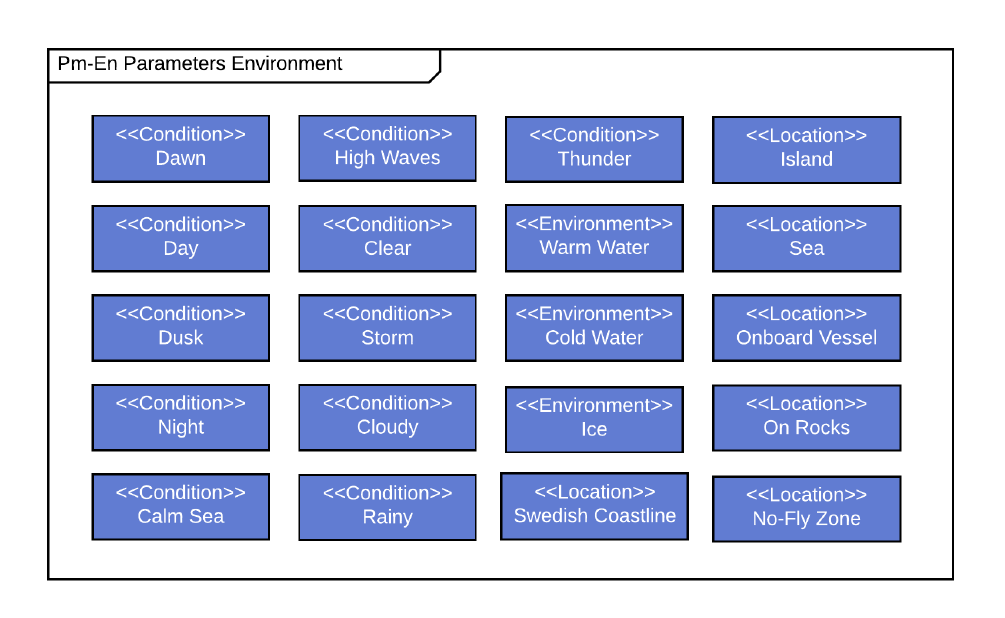
Figure 12. The Parameters Environment (Pm-En) view of the UAF, illustrating possible locations, conditions and environments that the SAR system can operate